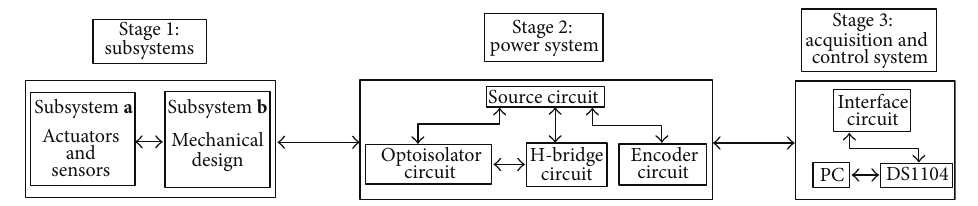
Figure 1: General block diagram of the WMR